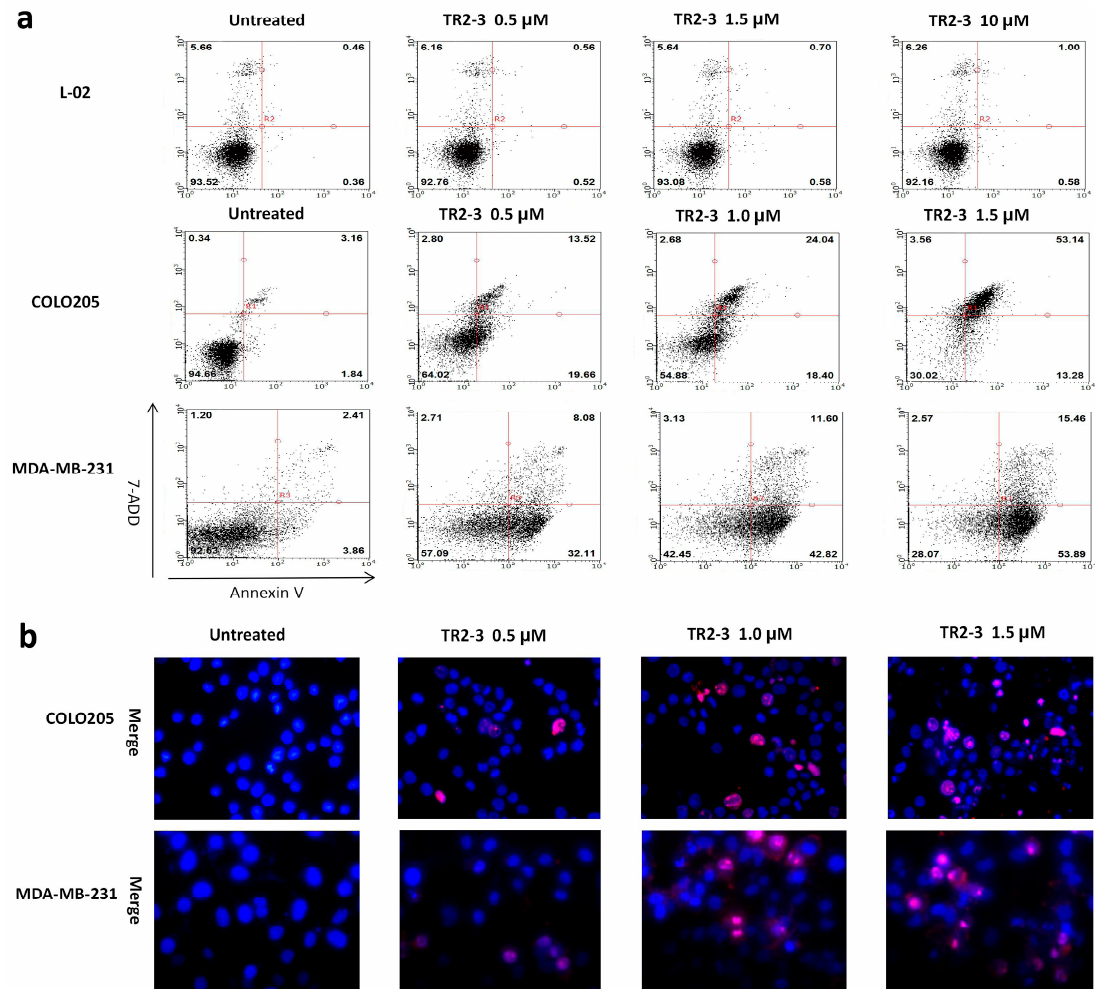
Figure 7. The apoptosis inducing activity of TR2-3 detected in cancer cells and normal cells. COLO205 and MDA-MB-231 cells were treated with 0.5, 1.0, and 1.5 µ M or without TR2-3 for 4 h. L-02 cells were treated with a concentration of 1.0, 1.5 and 10 µ M or without TR2-3 for 72 h. ( a ) Treated cells were stained by Annexin V-FITC and 7-AAD, counted by flow cytometer (10,000 cells per sample); ( b ) Cells were subjected to Hoechst 33342 (in blue) and propidium iodide (in red) dual staining assays and imaged under a fluorescence microscope (400 × ). These data are representative of at least three independent experiments.